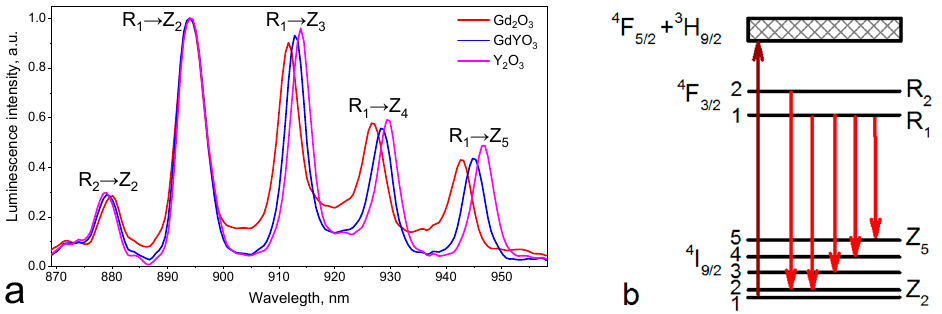
Figure 5. ( a ) Fluorescence spectra of (Gd 1 − x Y x ) 2 O 3 crystalline powders at 4 F 3/2 → 4 I 9/2 band; ( b ) corresponding transitions between Stark sublevels.